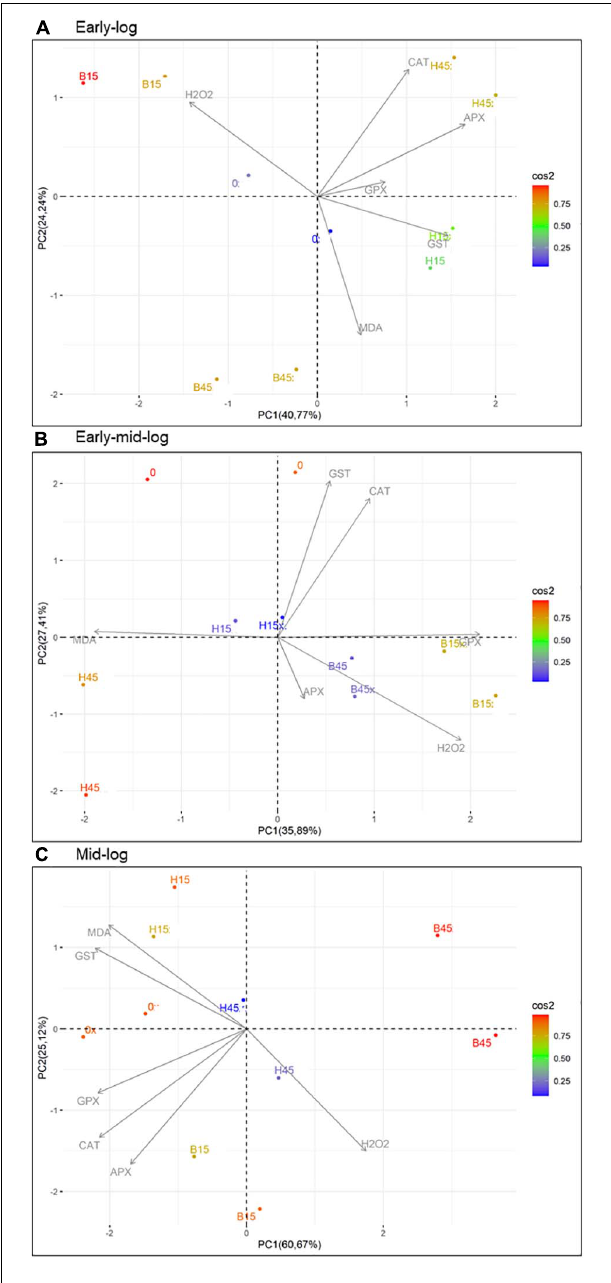
FIGURE 9 | PCA of the relationships between quantifications of stress indicators H 2 O 2 and MDA and profiles of enzymatic activities of CAT, APX, GPX, and GST of Pseudomonas sp. CMA 6.9 in the three growth phases indicated. (A) Early-log phase; (B) Early mid-log phase; (C) Mid-log. Color scale indicates the degree of contribution of the data distribution. CAT, catalase; APX, ascorbate peroxidase; GPX, guaiacol peroxidase; GST, glutathione